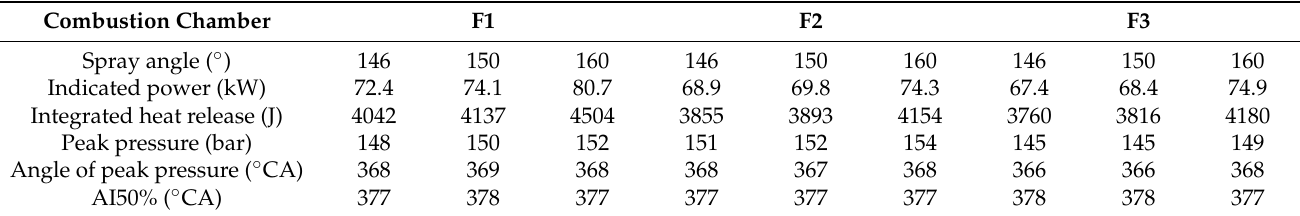
Table 10. Comparison of combustion performance of the three combustion